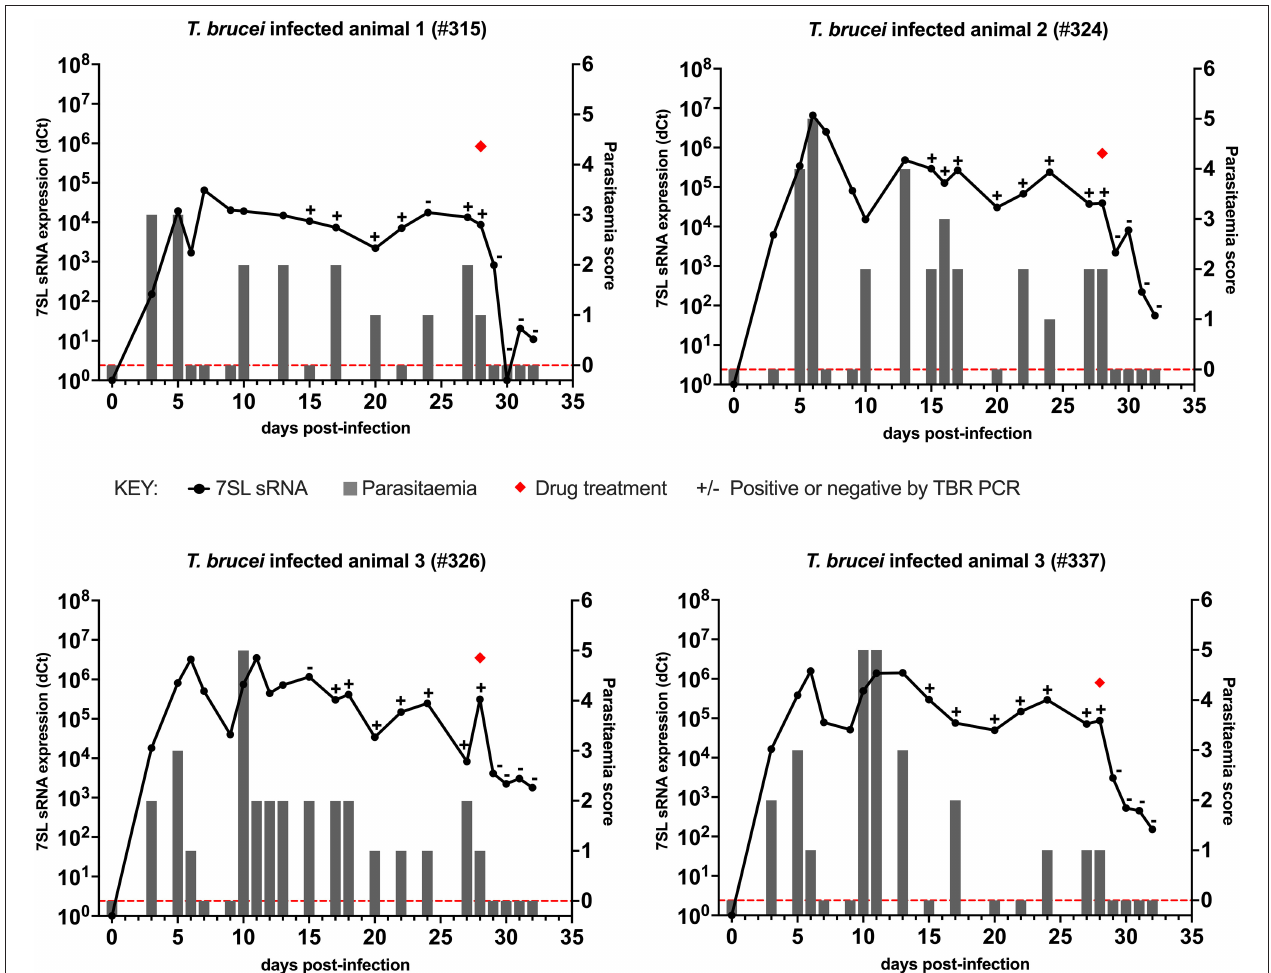
FIGURE 1 | Comparison of detection by buffy coat microscopy, TBR PCR and 7SL sRNA RT-qPCR in T. brucei infected calves. Four calves (Holstein-Friesian, approximately 4–6 months old) were infected with T. brucei Antat 1.1 (day 0) and monitored for 32 days. On day 28, calves were treated with diminazene aceturate, indicated by a red diamond. Parasitaemia (right y axis) was determined on average every 2 days by the BCT; days on which this was measured are indicated by gray bars. Approximate parasitaemia equivalences (trypanosomes/mL) of the score used: 1 = 1 × 10 2 ; 2 = 1 × 10 3 ; 3 = 5 × 10 3 -5 × 10 4 ; 4 = 1 × 10 4 -5 × 10 5 ; 5 = 5 × 10 5 -5 × 10 6 ; 6 = > 5 × 10 6 . Gray bars measuring 0 indicate time points in which parasitaemia was measured but no parasites were detected (0 on y axis is shown by red dotted line). Relative expression (dCt) of 7SL sRNA by RT-qPCR (left y axis) is shown with a black line and was calculated by normalizing to an uninfected control animal. TBR PCR results are shown by plus ( + ) or minus (–) signs indicating the presence or absence of the expected PCR band on an agarose gel,